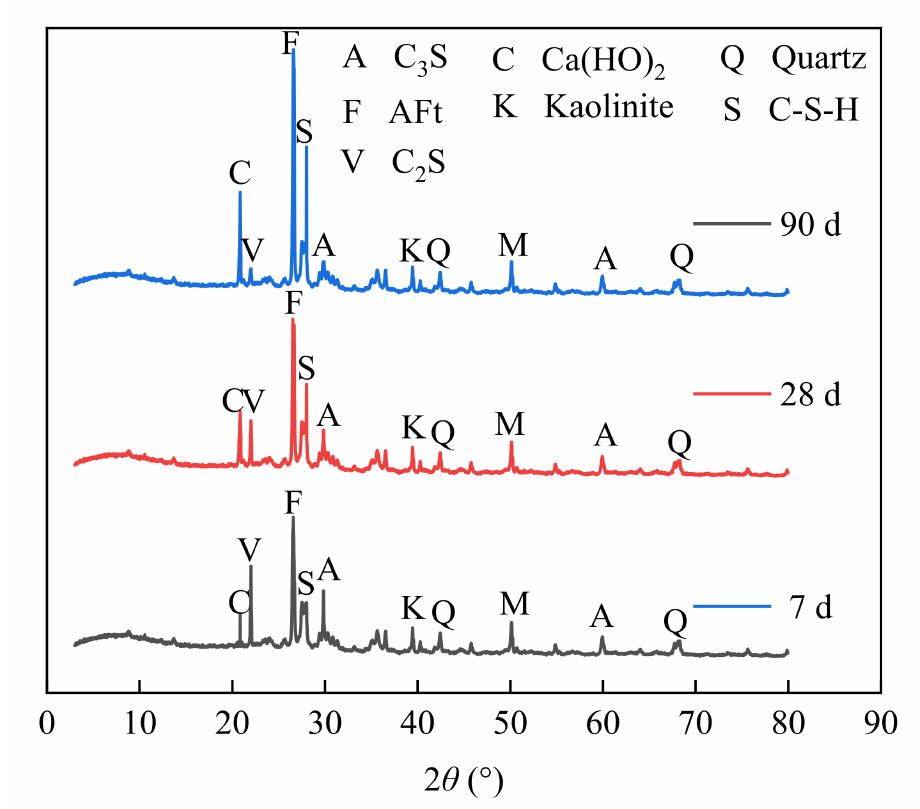
Figure 14. XRD detection at different